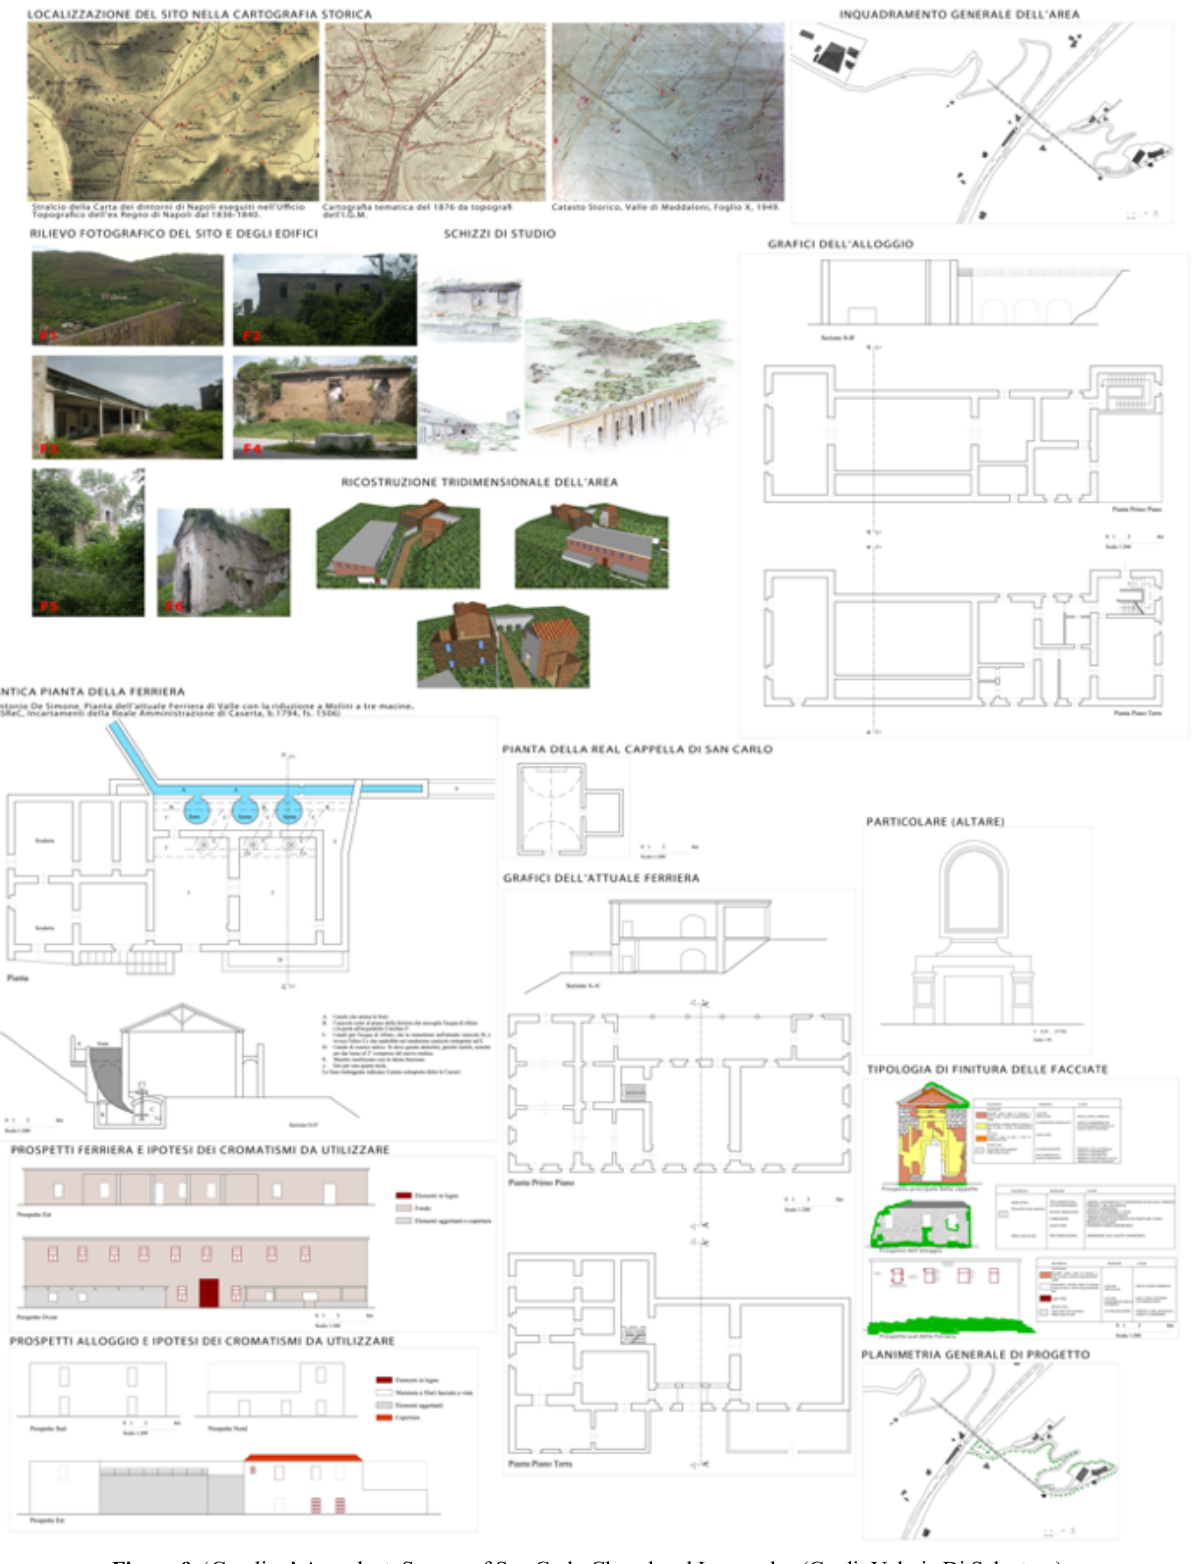
Figure 9 . ‘Carolino’ Aqueduct. Survey of San Carlo Chapel and Ironworks. (Credit Valeria Di